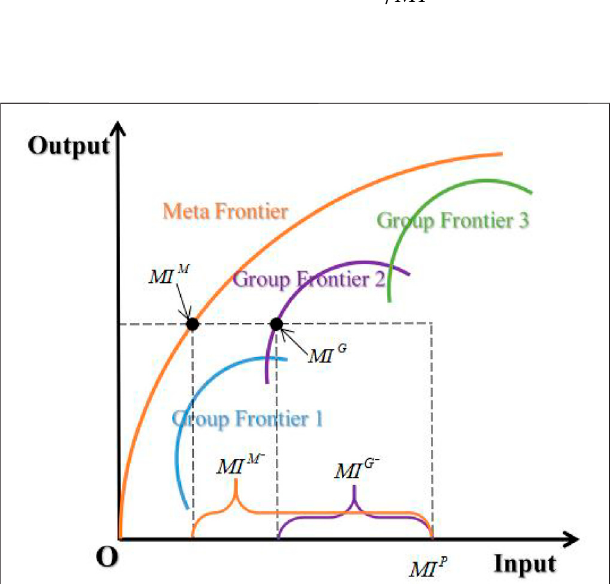
FIGURE 3 | L Meta Frontier model considering group